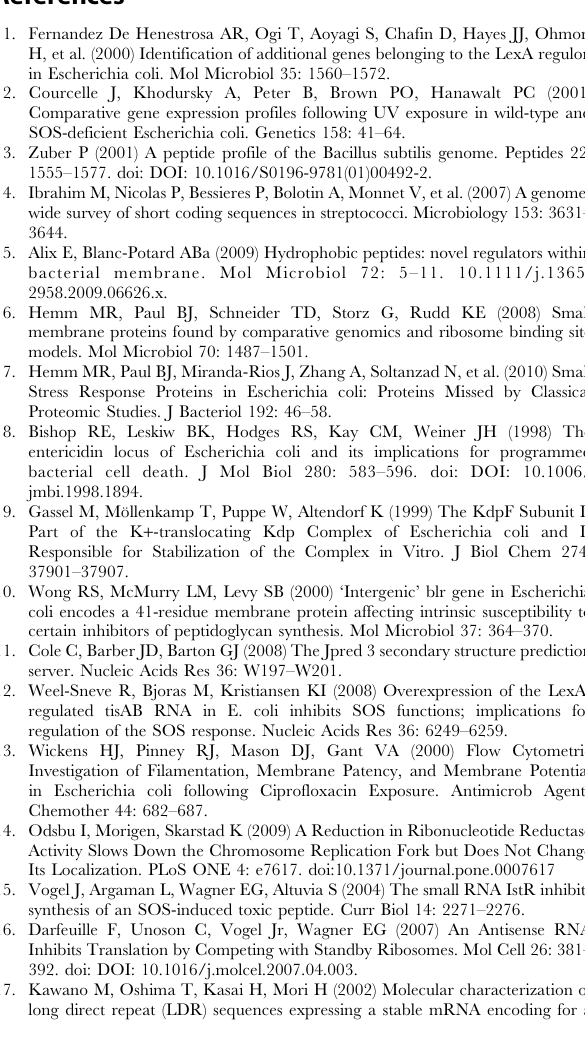
Table S2 Transformation efficiency. Exponentially growing cells of wt (AB1157) and agrB (BK4043/BK4180) were transformed by Dilutions were spread on LB plates and transformed cells were counted. Table S3 Oligonucleotides used in this